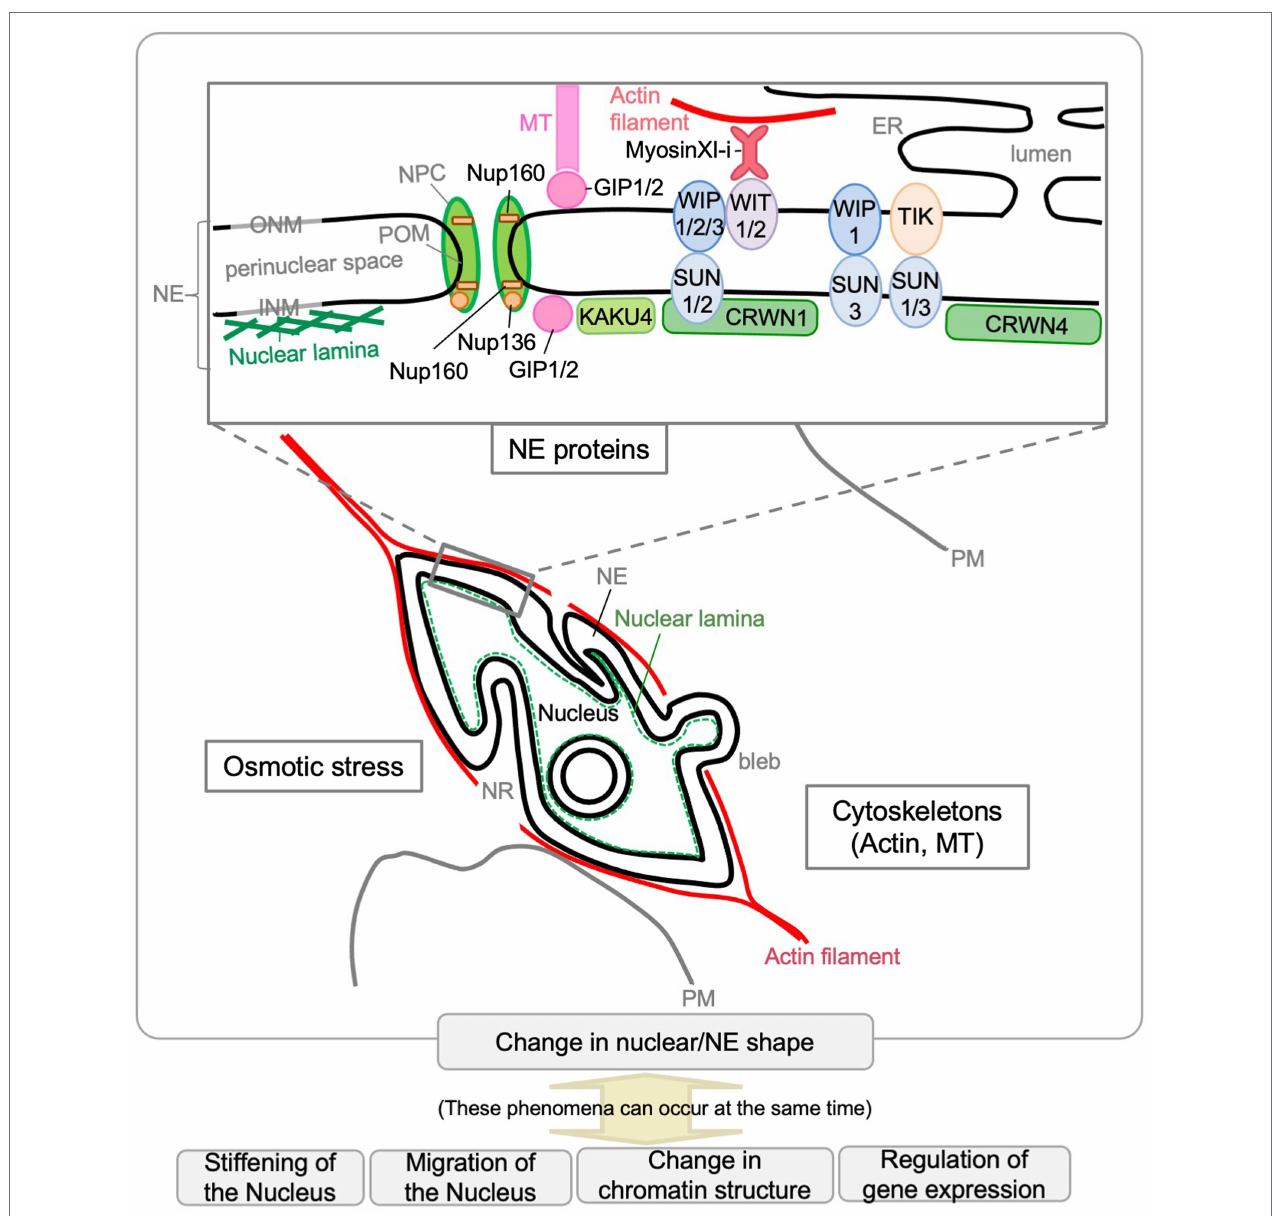
FIGURE 3 | Factors that affect the nuclear shape in plants. Scaffolding or other functions by NE proteins and cytoskeletons (actin and MTs) are involved in controlling the nuclear shape in plants. Osmotic stress affects nuclear shape. The Arabidopsis NE proteins that affect nuclear shape are depicted in the enlarged diagram of the NE structure. The phenomena shown at the bottom of the diagram can occur during nuclear shape